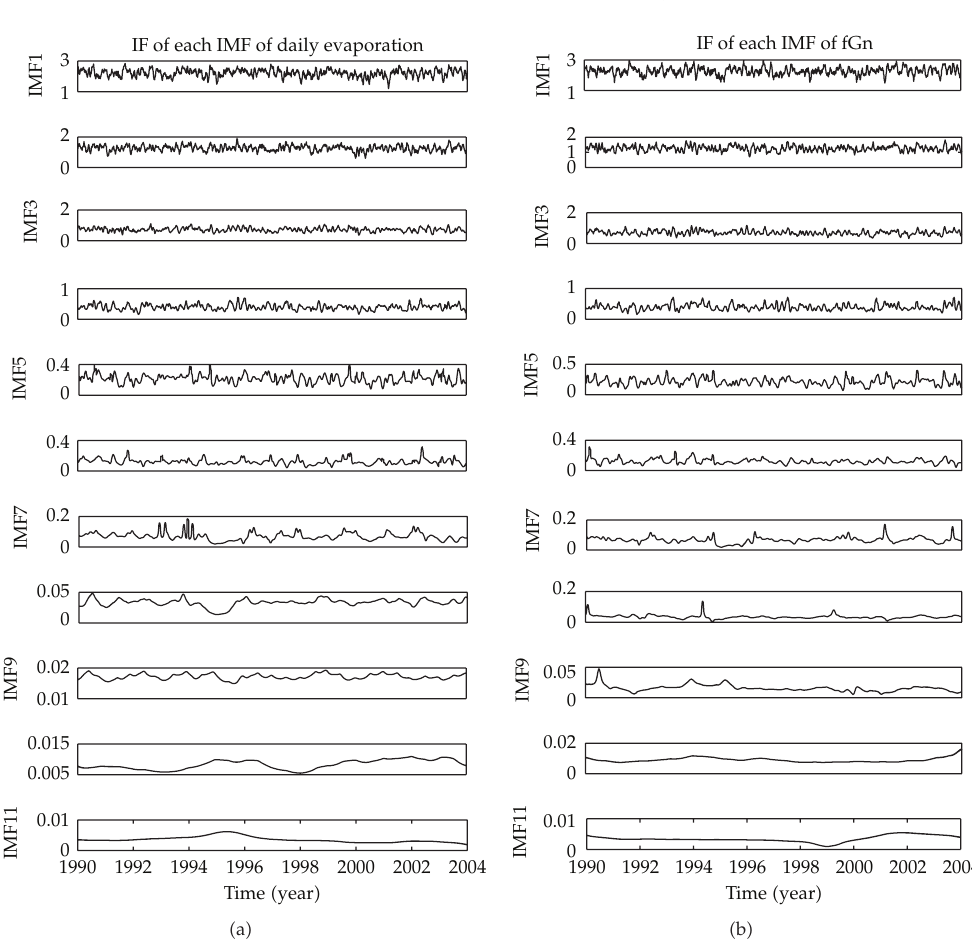
Figure 3: Instantaneous frequencies of the IMFs shown in Figure